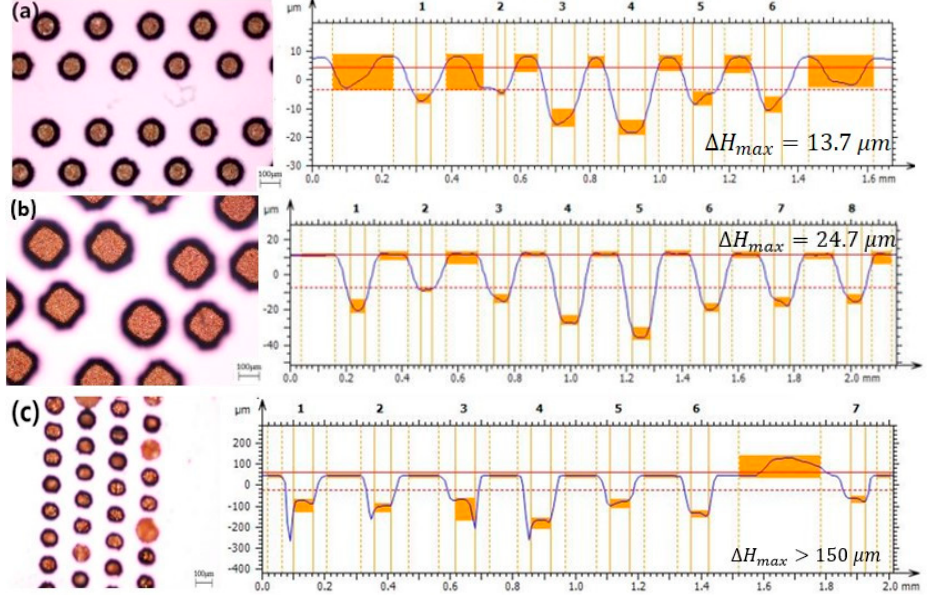
Figure 7. Top views and profile height diagram taken from the section with the greatest height difference using different shape holes using an optical microscope and a confocal displacement detector, respectively: ( a ) circle, ( b ) square, and ( c ) oval holes.